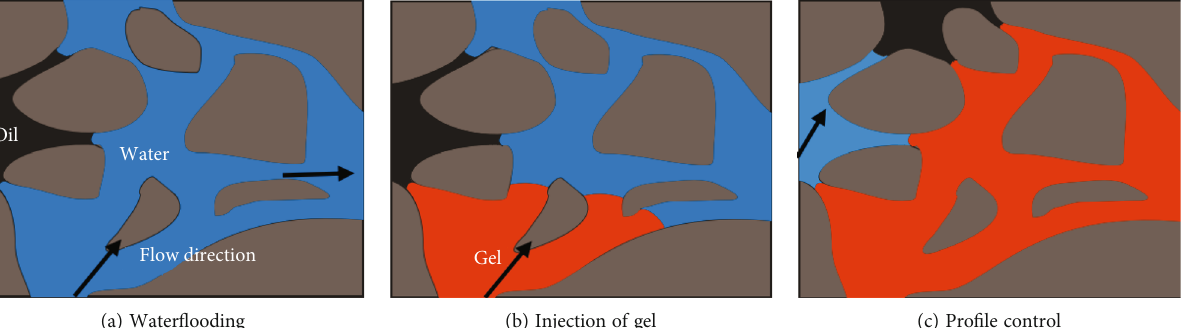
Figure 3: General sketch of the problem under study.